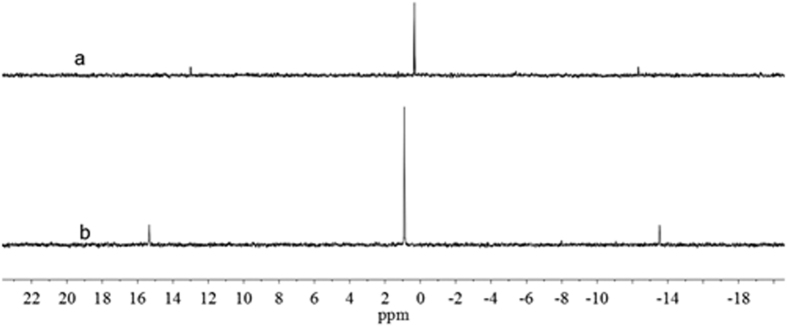
31P NMR spectra of the discrete [6+4] SCCs 4 and [6+3] SCCs 5.